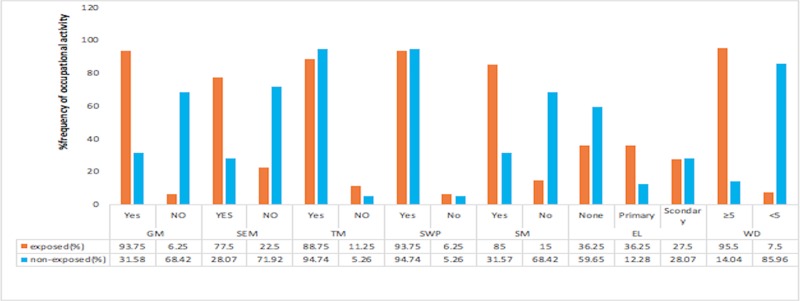
Percentage frequencies of occupational activities among small scale miners stratified by mercury exposure.GM- Gold amalgamation, SEM- sucking of excess mercury, TM- transport of mercury, SWP- standing in water pool, SM- smelting of gold, EL- Educational level, WD-work duration.